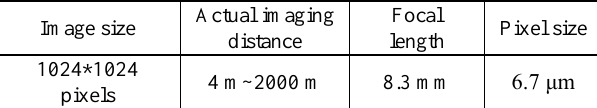
Table 1. Technical parameters of CE-3 descent camera